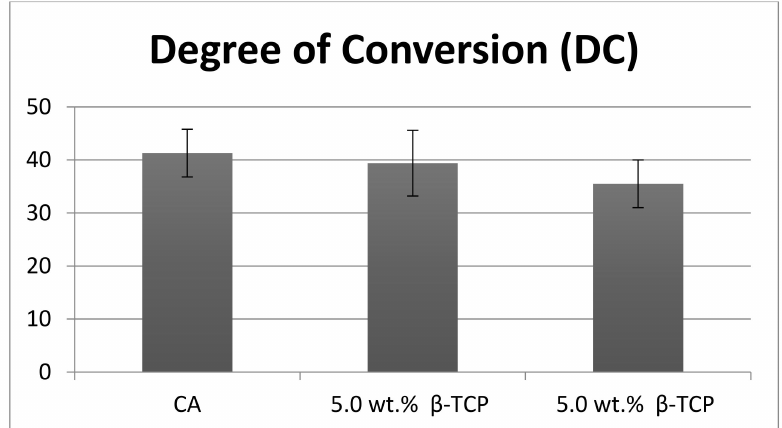
Figure 5. Comparison of DC among the study groups. CA: control